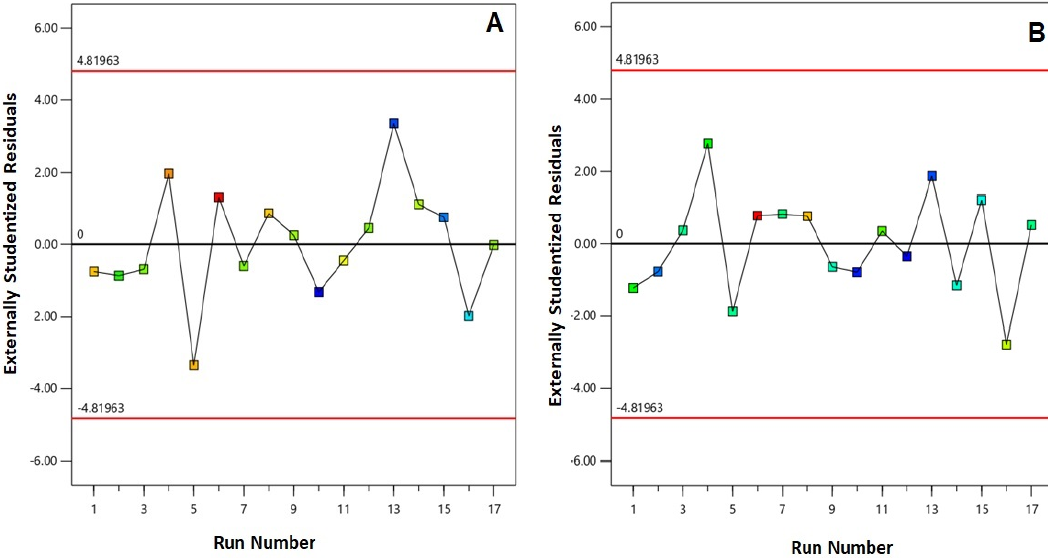
Figure 1. Externally studentized residual plot versus run for ( A ) particle size and ( B ) entrapment e ffi ciency% of PIC-E. Table 4. Quadratic model statistics of PIC-E responses.